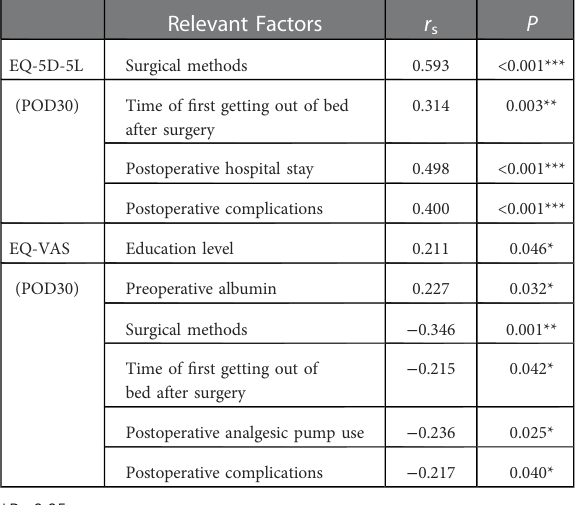
TABLE 4 Analysis of related factors with EQ-5D score at 30th day after